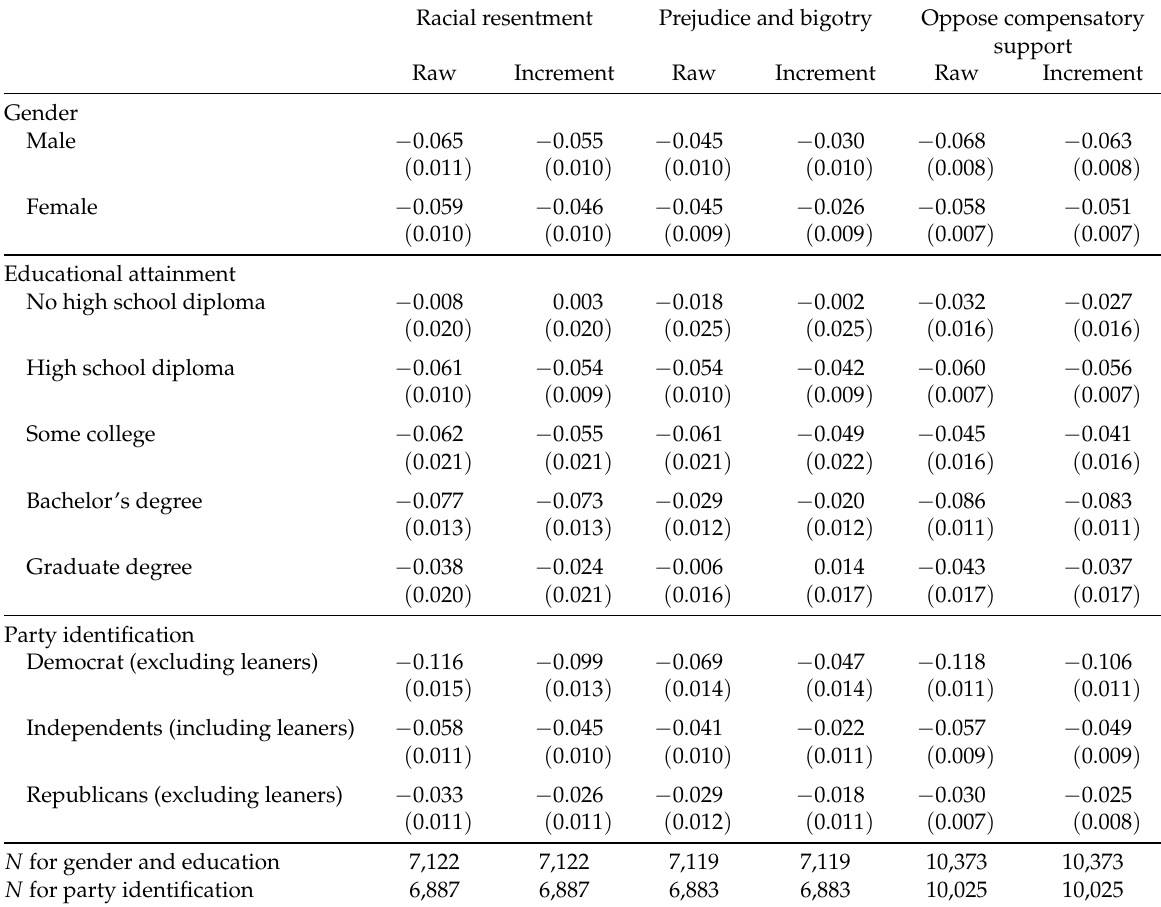
Table 5: Raw and incremental change per year for the period effects on racial attitudes from 2012 through 2018 for white-only, non-Hispanic